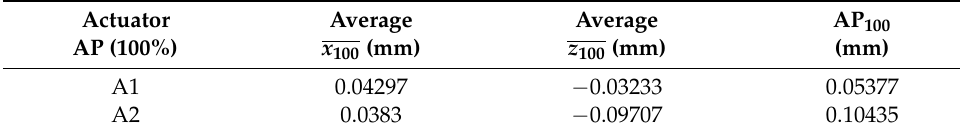
Table 4. Calculated AP 100 values of actuators under full